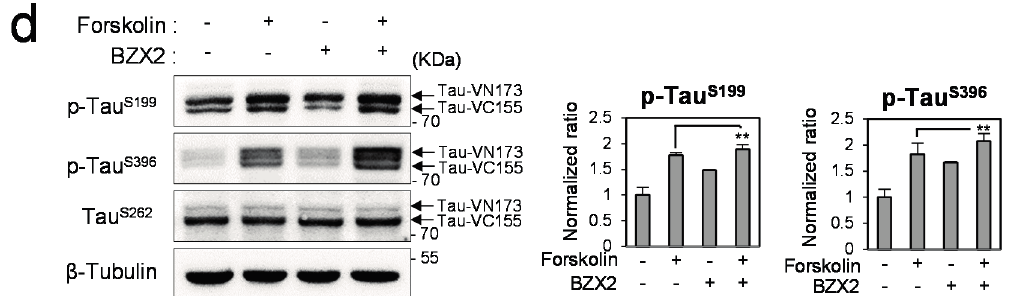
Figure 2. The regulatory effect of O -GlcNAcylation under tau hyperphosphorylation. ( a , b ) Tau-BiFC cells were treated with Thiamet G or BZX2 (25, 50 and 100 µM)